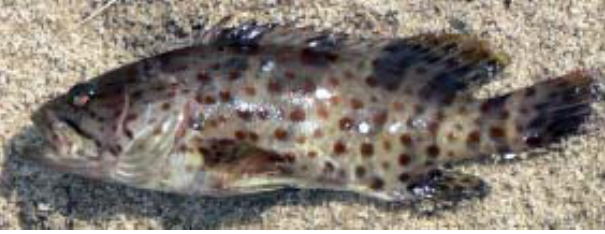
Image 26. Greasy Grouper Epinephelus tauvina